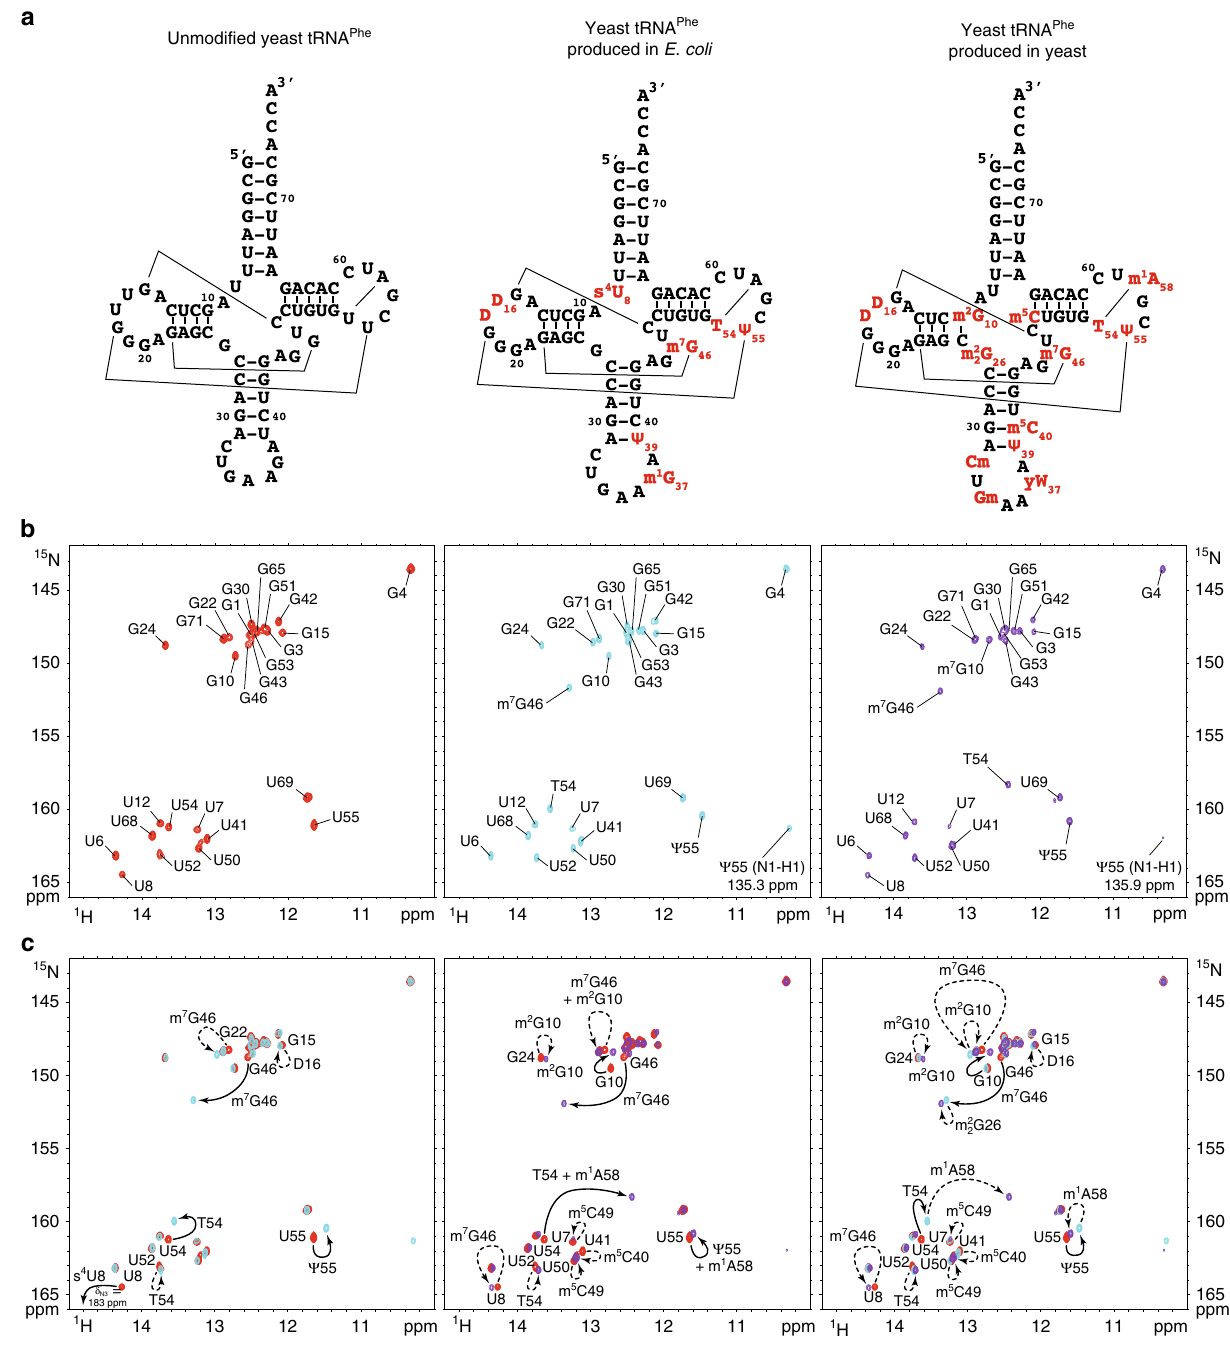
Fig. 3 The comparison of different maturation states gives the NMR signature of individual modi fi cations. a Sequence and cloverleaf representation of unmodi fi ed yeast tRNA Phe produced by in vitro transcription (left), yeast tRNA Phe produced and modi fi ed in E. coli (middle), and yeast tRNA Phe produced and modi fi ed in yeast (right). Main tertiary interactions are represented with thin lines. Modi fi cations are in red. b Imino ( 1 H, 15 N) correlation spectra and imino group assignments of 15 N-labeled tRNA Phe measured in vitro: (left) unmodi fi ed yeast tRNA Phe , spectrum in red; (middle) yeast tRNA Phe produced and modi fi ed in E. coli , spectrum in cyan; (right) yeast tRNA Phe produced and modi fi ed in yeast, spectrum in purple. c Superposition of imino ( 1 H, 15 N) correlation spectra of various tRNA Phe samples and NMR signature of individual modi fi cations: (left) unmodi fi ed (red) and E. coli -modi fi ed (cyan); (middle) unmodi fi ed (red) and yeast-modi fi ed (purple); (right) unmodi fi ed (red), E. coli -modi fi ed (cyan), and yeast-modi fi ed (purple). A selection of imino assignments is reported on the spectra. NMR signatures of modi fi cations are reported with continuous line arrows (direct effects — see main text), or dashed arrows (indirect effects) dashed line arrows for direct and indirect effects, respectively